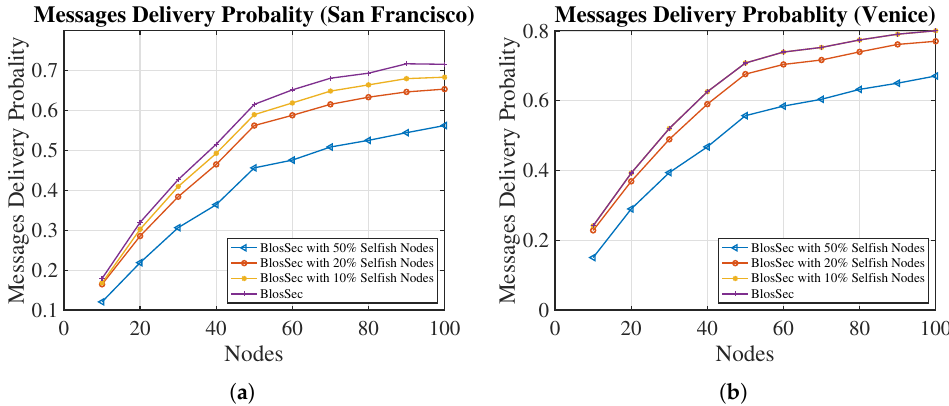
Figure 10. Comparison of the messages delivery probability of BlosSec in networks with selfish nodes dropping 20% of their messages. ( a ) San Francisco; ( b ) Venice.